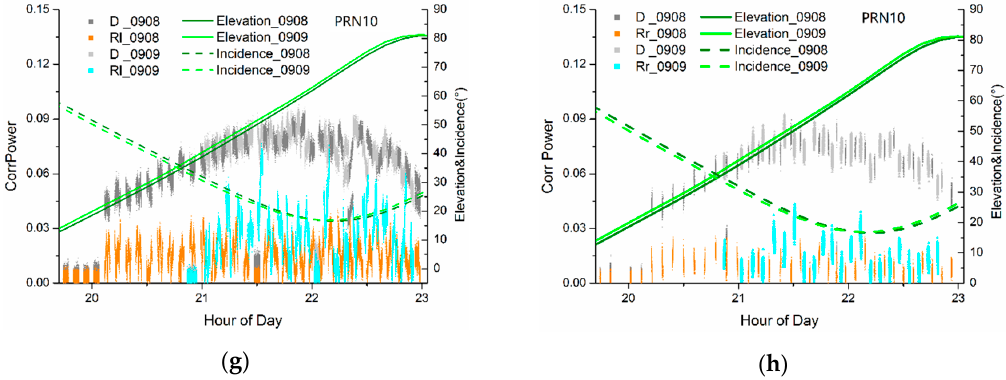
Figure 7. Correlation power of the direct and reflected signals in contrast with the elevation and incidence angles with respect to the antenna for different PRNs. ( a ) Direct, D, and LHCP reflected signals, Rl, of PRN 02, ( b ) direct, D, and RHCP reflected signals, Rr, of PRN 02, ( c ) direct, D, and LHCP reflected signals, Rl of PRN 05, ( d ) direct, D, and RHCP reflected signals, Rr of PRN 05, ( e ) direct, D, and LHCP reflected signals, Rl of PRN 06, ( f ) direct, D, and RHCP reflected signals, Rr of PRN 06, ( g ) direct, D, and LHCP reflected signals, Rl of PRN 10, ( h ) direct, D, and RHCP reflected signals, Rr of PRN 10. The 0908 and 0909 respectively represent 8th and 9th September 2014 (As an exception, in this figure, the incidence angle represents the angle between antenna bore sight and the reflected signal).